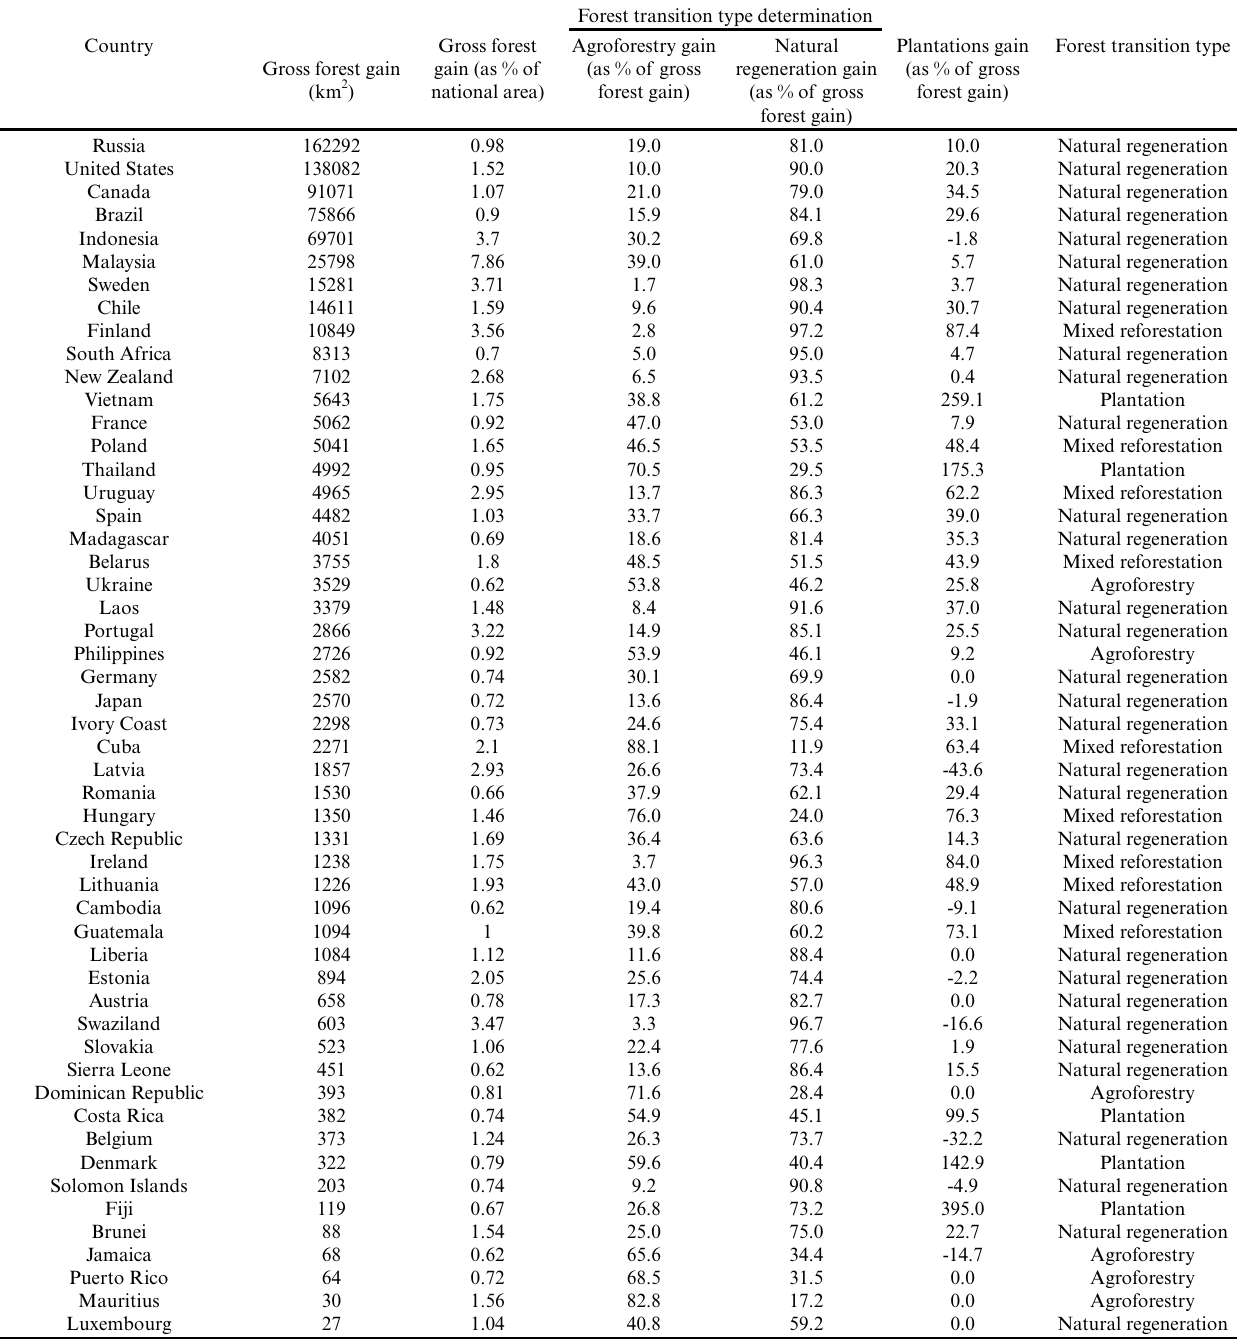
Table 1 . The 52 countries with the highest national proportional gross forest cover gain, and their dominant forest transition type. The dominant forest transition type was identified by the type of forest cover that accounted for most of the recovery (> 50%). When no forest type made up more than 50%, the transition was recorded as “mixed”. Since FAO forest resource assessment estimates of planted- forest gain are independent of Hansen estimates, forest gains through different pathways add to more than 100% when planted forest gains